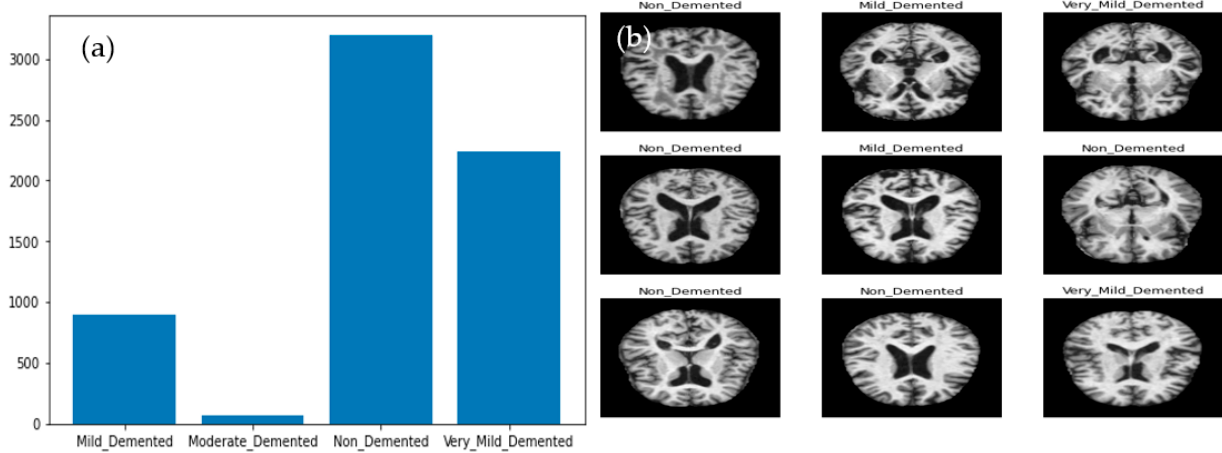
Figure 1. ( a ) Distribution of 4 different classes and ( b ) a sample image in the selected dataset.